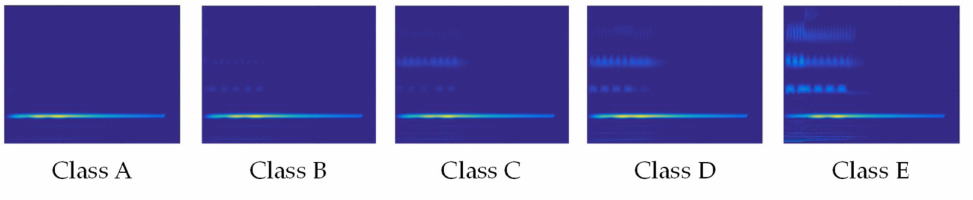
Figure 6. Displacement sample images of five randomly selected vehicle weights.